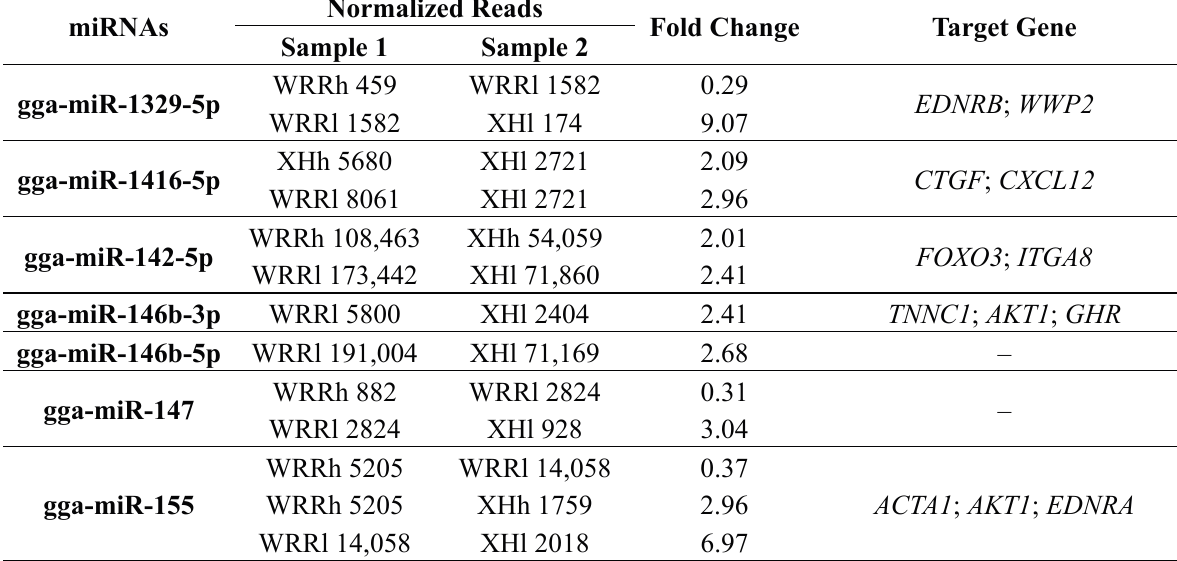
Table 4. Differently expressed miRNAs and their candidate target